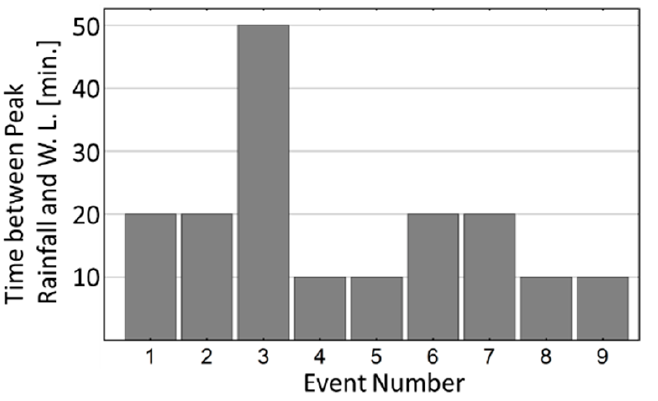
Figure 4. Difference in the time of the rainfall peak and water level peak for each torrential rainfall event. Table 1. Observed numerical data on rainfall and water levels at each event, with colored maxi- mum rainfall intensity and water level for each event.